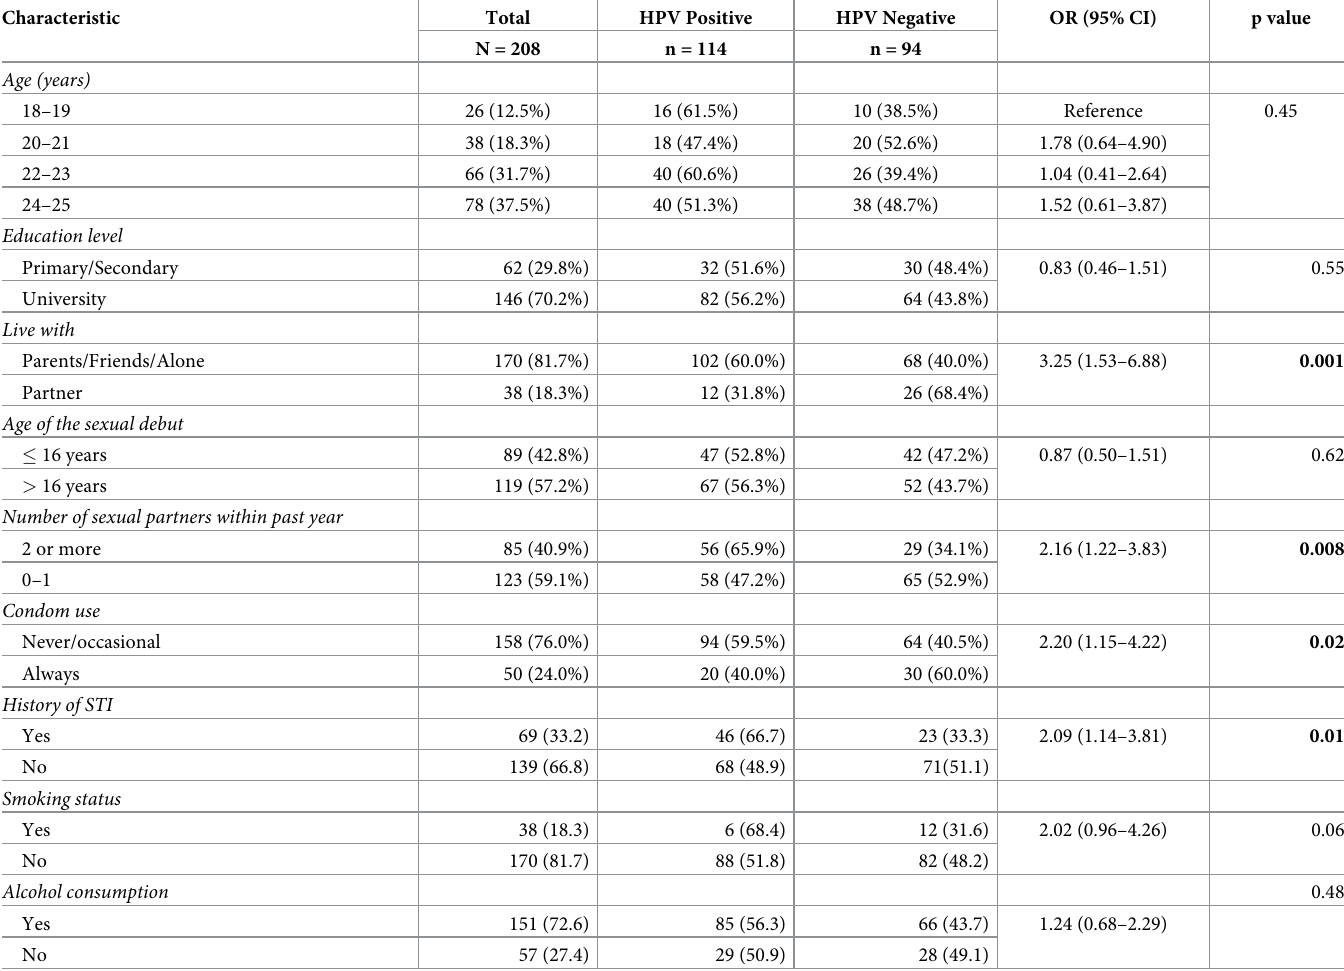
Table 1. Participant characteristics and behavioral factors associated with HPV infection in young women from Paraguay.